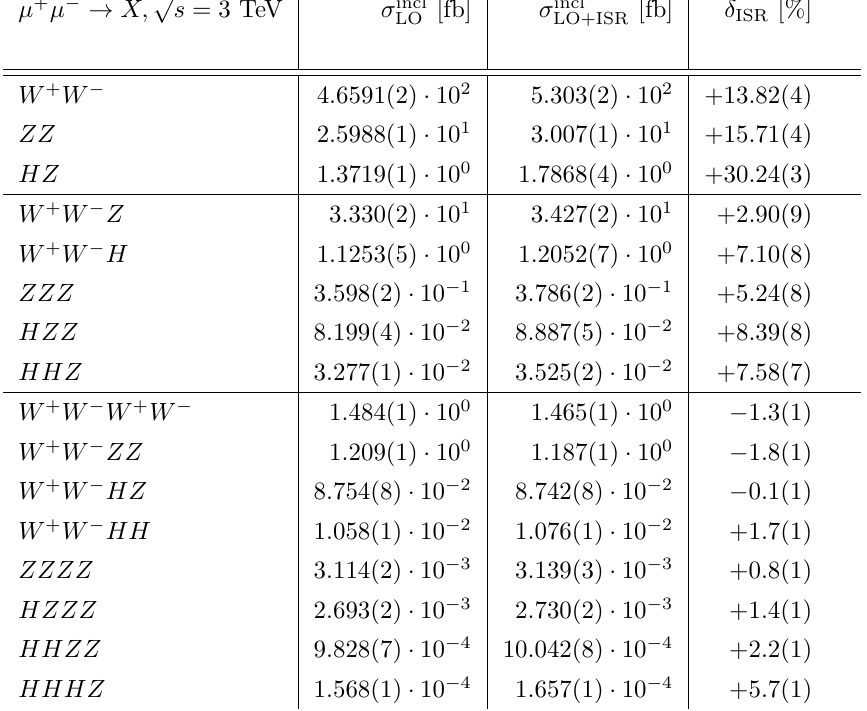
Table 4 . Total inclusive cross sections at LO with LL ISR photon resummation, and including relative correction δ ISR for two-, three- and four-boson production at